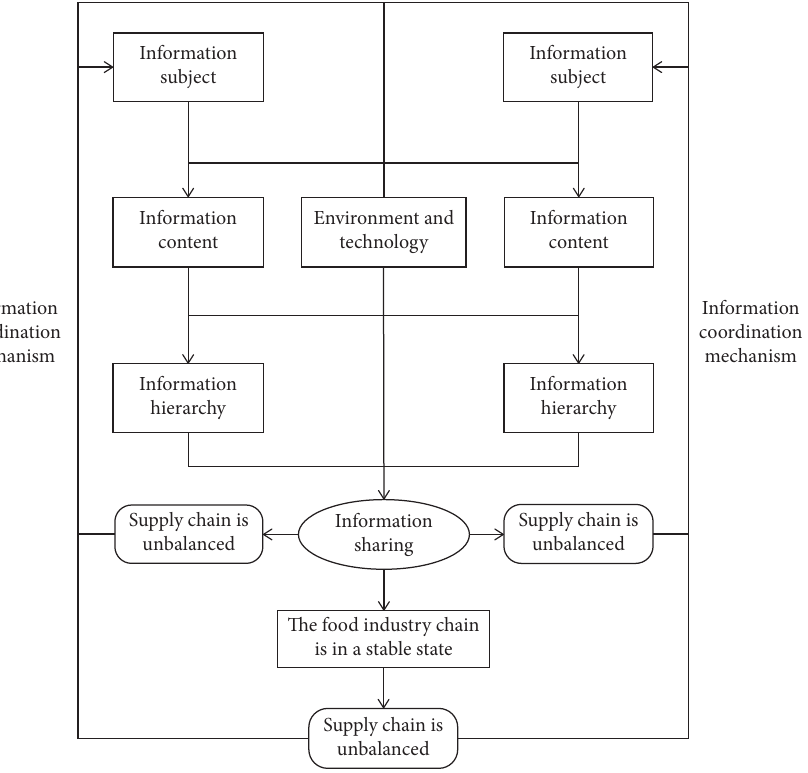
Figure 7: Logistics supply chain information coordination model.